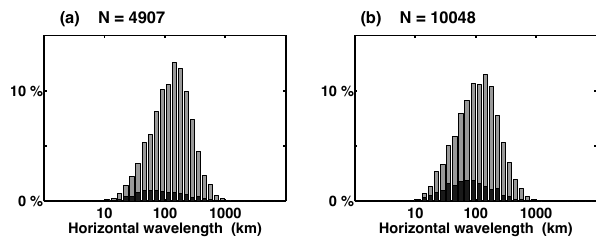
Figure 8. Distribution of horizontal wavelength for summer (a) and winter (b) season. Grey and black parts of the histogram represent the upward and downward energy propagating IGWs respectively.